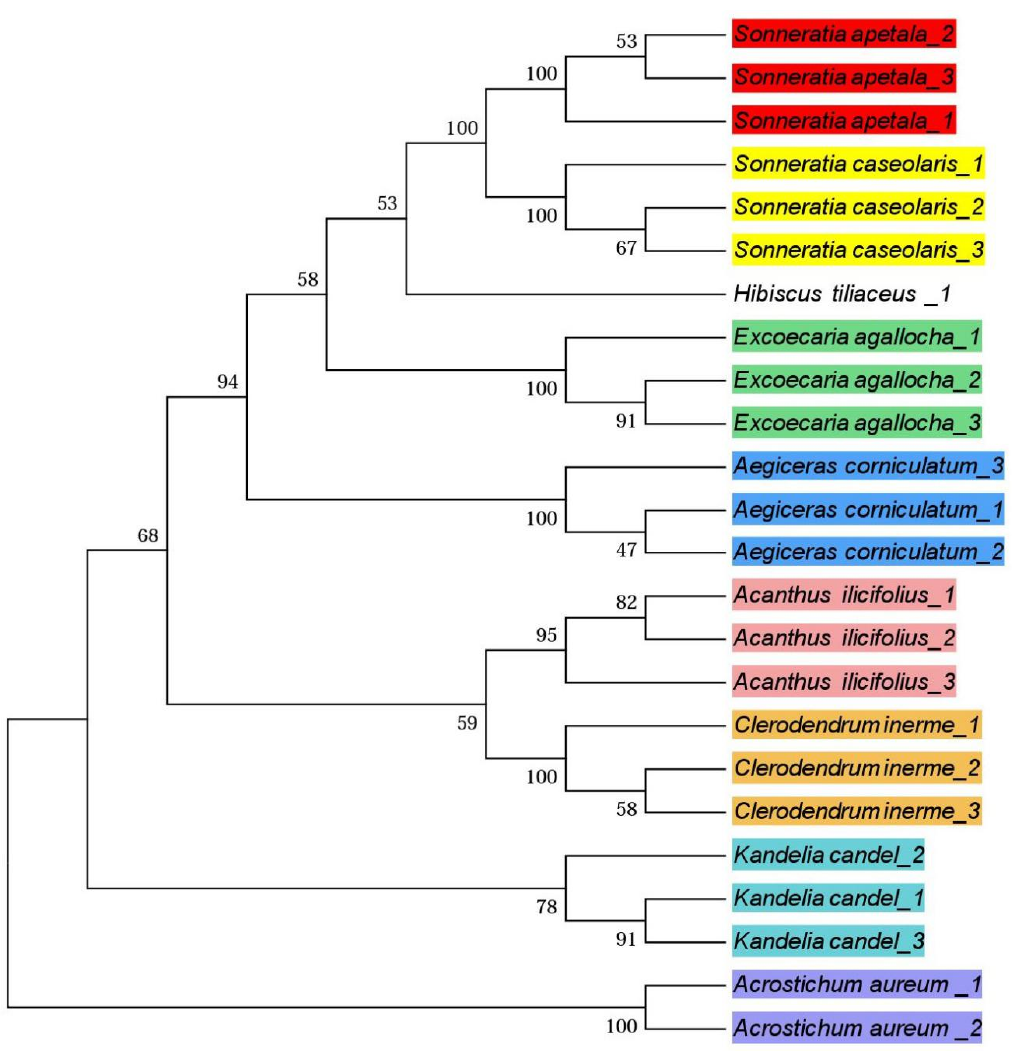
Figure 5. The phylogenetic tree of mangroves in Shantou using fragment of matK + rbcL + trnH-psbA +